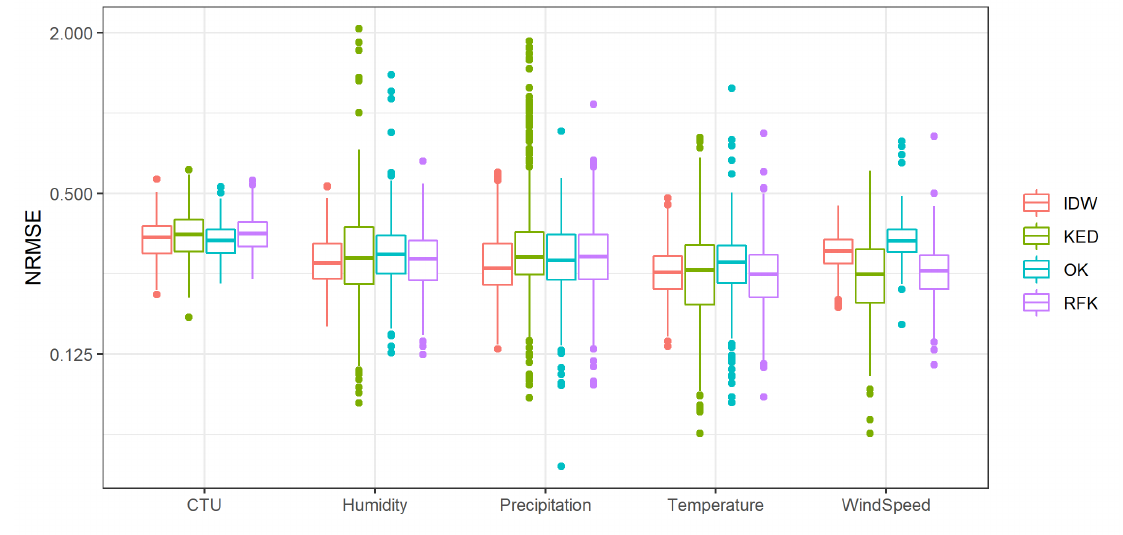
Figure 3. Normalised root mean squared error (NRMSE) of different deterministic and stochastic interpolation methods for the weather parameters cumulative thermal units (CTU), air humidity (%), temperature ( ◦ C ), precipitation (mm/h), and wind speed